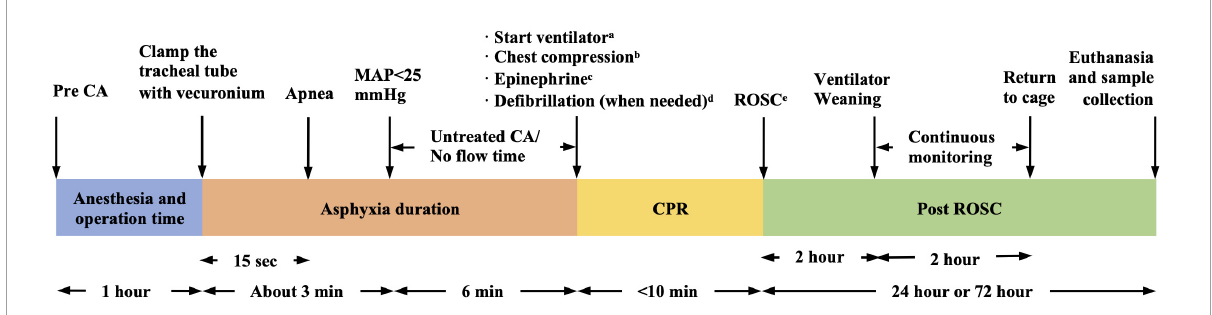
FIGURE1 Six-min asphyxia cardiac arrest (ACA)/CPR model protocol (our protocol as an example). a FiO 2 = 1.0, frequency of 100/min, tidal volume of 0.65 ml/100 g. b Manually, 200–300/min, at a depth of 1/3 the anterior–posterior chest diameter. c 0.01 mg/kg, every 2 min. d Single 2J rectilinear biphasic shock. e MAP > 60 mmHg lasting for ≥ 10 min. CA, cardiac arrest; CPR, cardiopulmonary resuscitation; ROSC, return of spontaneous circulation; MAP, mean arterial